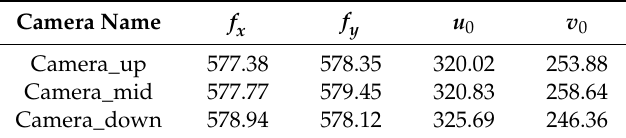
Table 2. Intrinsic parameters of each camera.